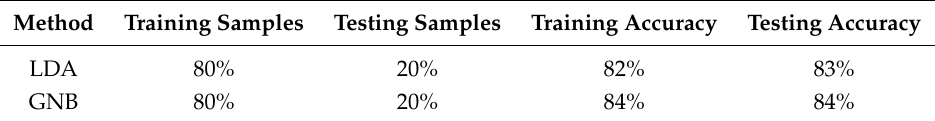
Table 5. Results for head pose classification.